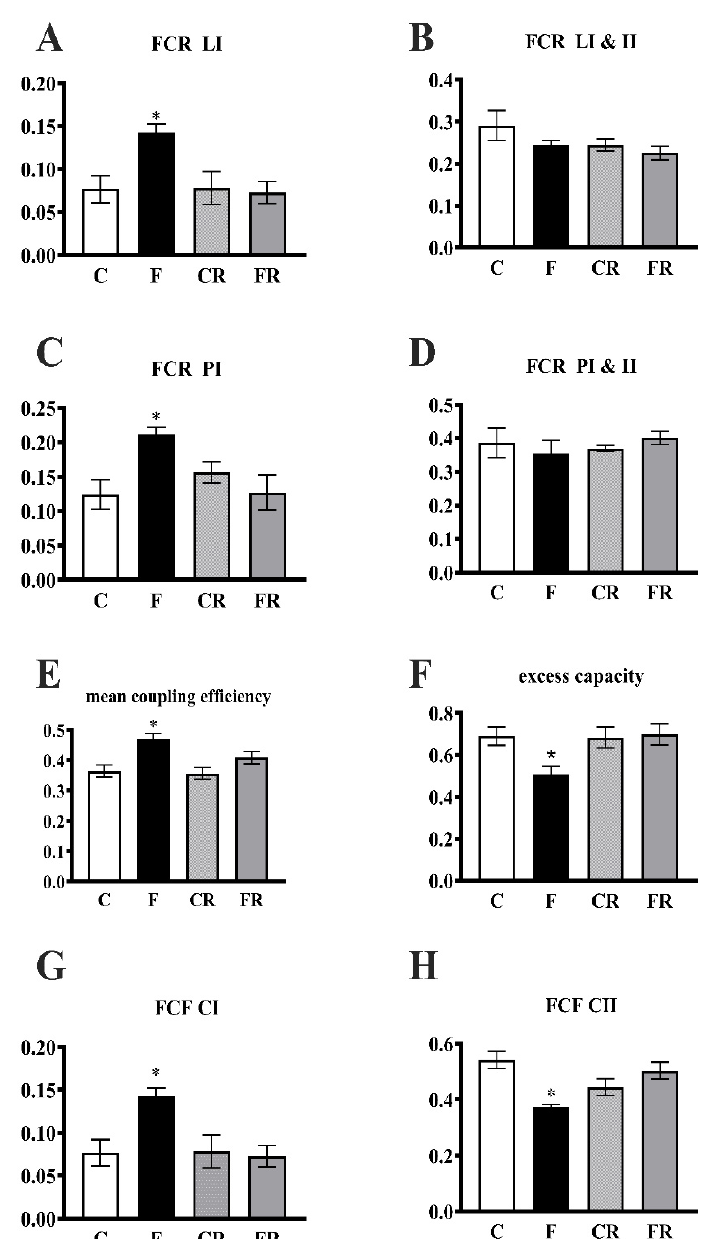
Figure 5. Integrated pathway of the electron transport chain in the hippocampus. Leak respiration with electron provision from complex I (FCR LI) (CIL)/(CI&IIE) ( A ) and complexes I and II (FCR L CI&II (CI&IIL/CI&IIE) ( B ), phosphorylating respiration with electron provision from complex I (FCR PI) (CIP/CI&IIE) ( C ) and complexes I and II (FCR PI&II) (CI&IIP/CI&IIE) ( D ), coupling efficiency of oxidative phosphorylation (1—CI&IIL/CI&IIP) ( E ), apparent excess capacity of the electron transport chain (1—CI&IIP/CI&IIE) ( F ), flux control factor (FCF) for complex I ( G ) and complex II ( H ) in the hippocampi from control (C), fructose-fed (F), control-rescued (CR), and fructose-rescued (FR) rats. Values are the means ± SEM of eight different rats. * p < 0.05 compared to C rats. Source of variation: one-way ANOVA followed by Tukey’s post-test. CIL = leak respiration with complex I substrate; CI&IIL = leak respiration with complex I and II substrates; CIP = phosphorylating respiration with complex I substrate; CI&IIP = phosphorylating respiration with complex I and II substrates; CI&IIE = maximum capacity of the electron transport chain with complex I and II